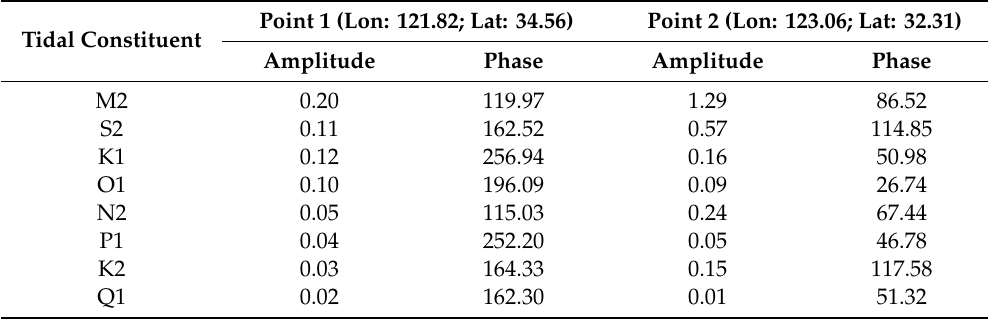
Table 1. The positions and 8 tidal